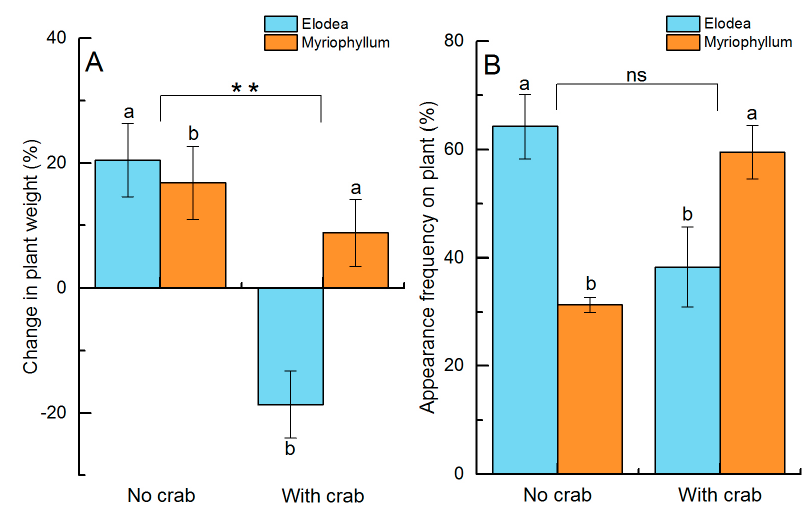
Figure 3. Differences in herbivory selection and refuge selection by experimental crabs between Elodea and Myriophyllum . Error bars represent standard deviation ( n = 3, %). Different letters above the bars denote significant differences between the two plants at p < 0.05. ** indicates significant differences between crab treatments at p < 0.01, while ns indicates no significance. Table 2. Summary of two-way ANOVA results in the refuge selection experiment.